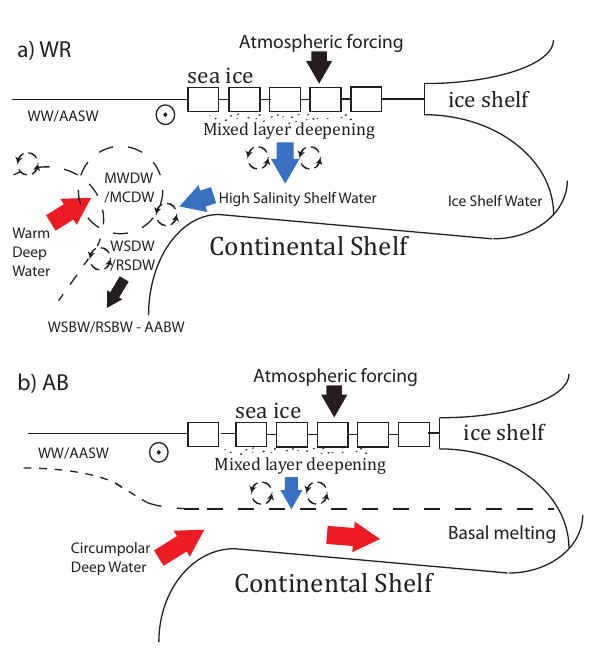
Fig. 3. Schematic of main processes in the (a) Weddell/Ross (WR) and (b) Amundsen/Bellingshausen (AB) shelf seas. AASW: Antarc- tic Surface Water , CDW: Circumpolar Deep Water, MCDW: Mod- ified Circumpolar Deep Water, MWDW: Modified Warm Deep Wa- ter, RSBW: Ross Sea Bottom Water, RSDW: Ross Sea Deep Wa- ter, WDW: Warm Deep Water, WSBW: Weddell Sea Bottom Water, WSDW: Weddell Sea Deep Water, WW: Winter Water. The dotted circle indicates the westward flowing slope